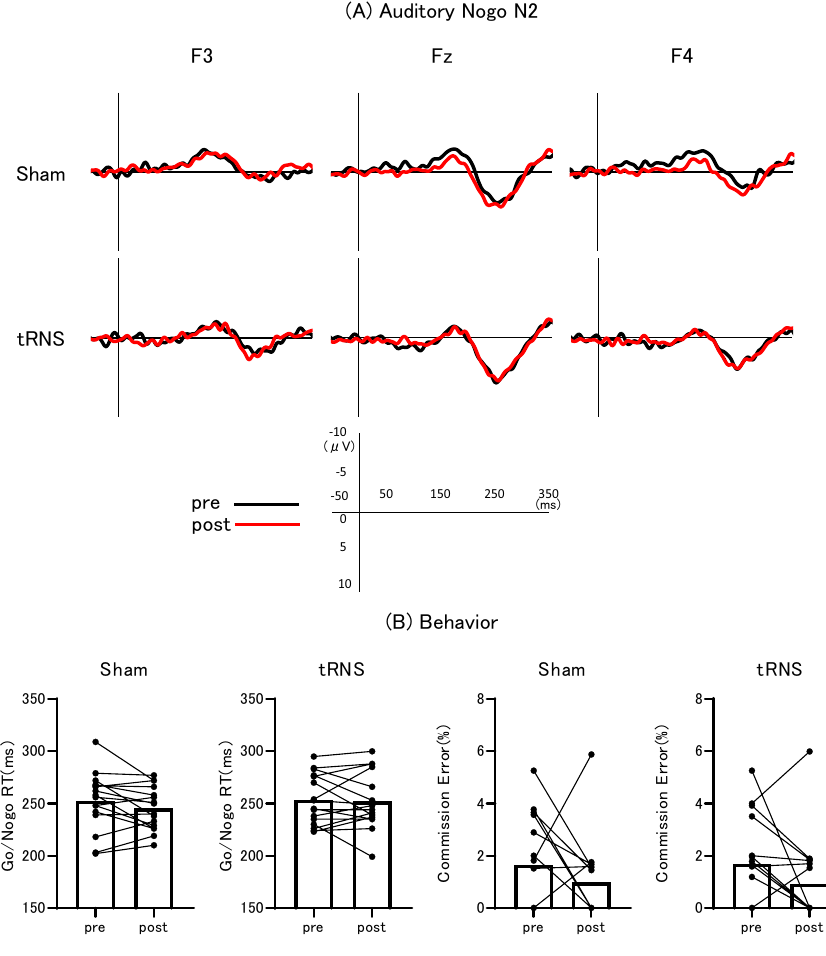
Figure 3. Grand-averaged auditory Nogo N2 waveforms and task performance. ( A ) Grand-averaged auditory Nogo N2 waveforms at electrode positions F3, Fz, and F4 before sham or tRNS (pre, black lines) and after sham or tRNS (post, red lines). ( B ) Within-subject and mean Go/Nogo reaction times (RTs, left panels) and commission error rates (right panels) before (pre) and after (post) sham and